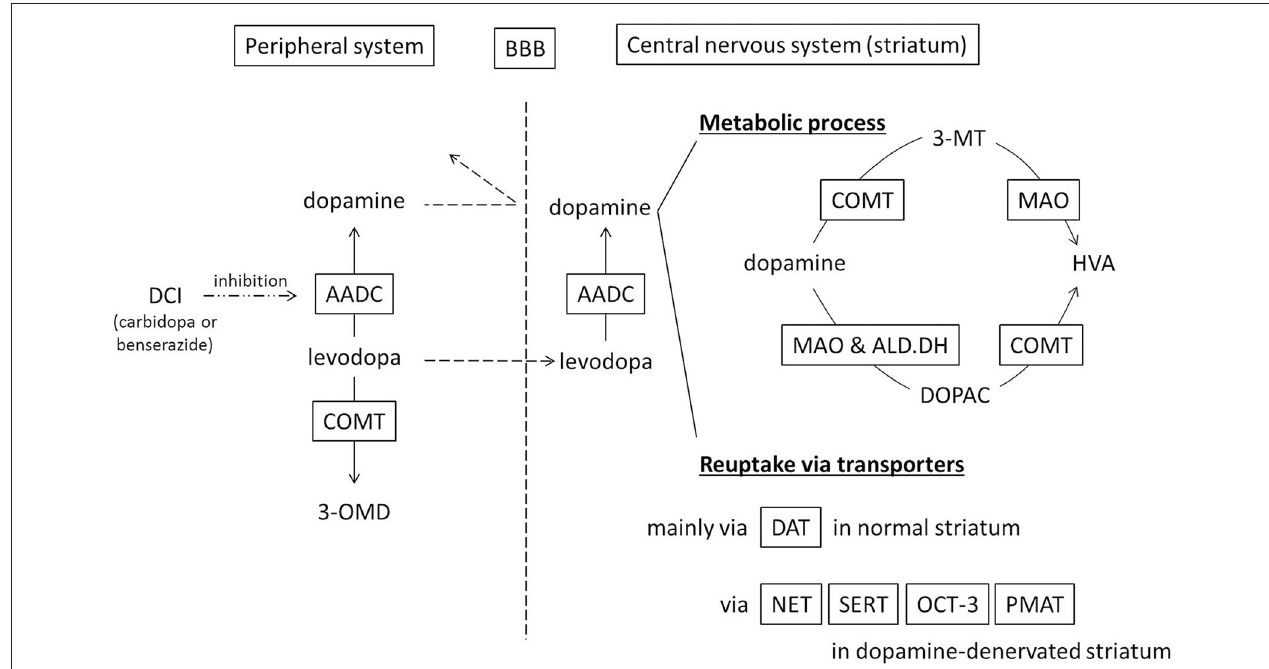
FIGURE 1 | Schematic diagram showing metabolism and uptake of levodopa-derived dopamine. Levodopa therapy is usually combined with a dopa-decarboxylase inhibitor (carbidopa or benserazide) in order to minimize peripheral conversion of levodopa. 3-MT, 3-methoxytyramine; 3-OMD, 3-O-methyldopa; AADC, aromatic amino acid decarboxylase; ALD.DH, aldehyde dehydrogenase; BBB, blood–brain barrier; COMT, catechol-O-methyltransferase; DAT, dopamine transporter; DCI, dopa-decarboxylase inhibitor; DOPAC, dihydroxyphenylacetic acid; HVA, homovanillic acid; MAO, monoamine oxidase; NET, norepinephrine transporter, noradrenaline transporter; OCT-3, organic cation transporter-3; PMAT, plasma membrane monoamine transporter; SERT, serotonin